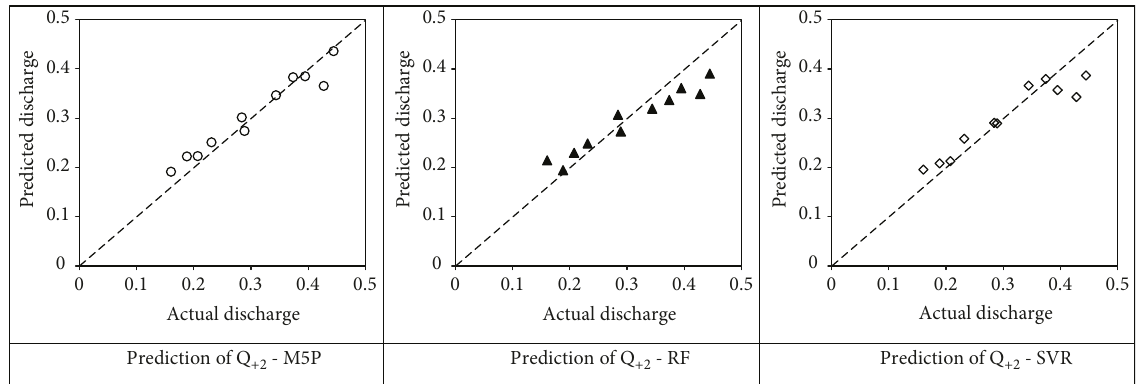
Prediction of Q + 2 - M5P Prediction of Q + 2 - RF Prediction of Q + 2 - Figure 12: Comparison between predicted and observed discharges (m 3 /s), 6-month input.